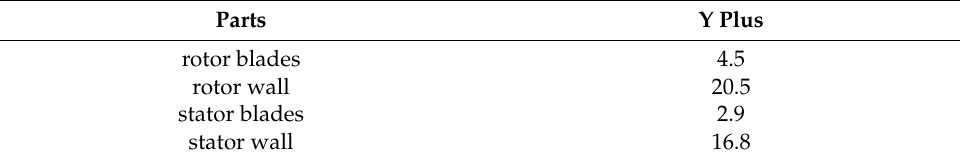
Figure 11. Pump-jet propulsion mesh. Table 3. The Y+ of rotor and stator